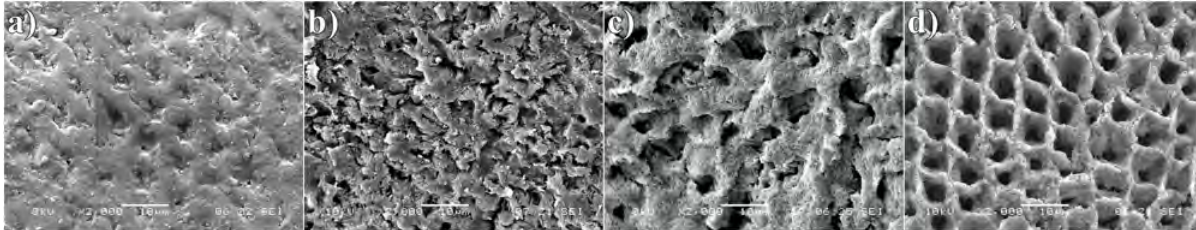
Figure 3. The surface of enamel exposed to drinks for 12 hours: a) intact enamel; b) Coca-Cola, pH 2.5; c) Fanta, pH 2.8; d) Sprite pH 2.7. (SEM, JSM5500-LV, Jeol, Tokyo,